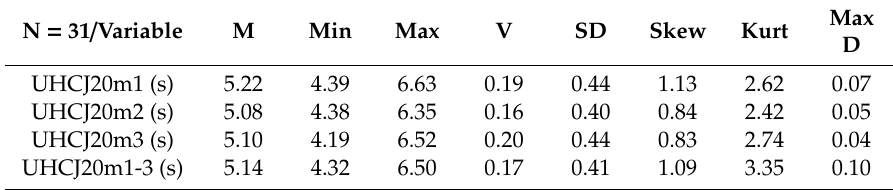
Table 2. Descriptive indicators of the UHCJ20m test